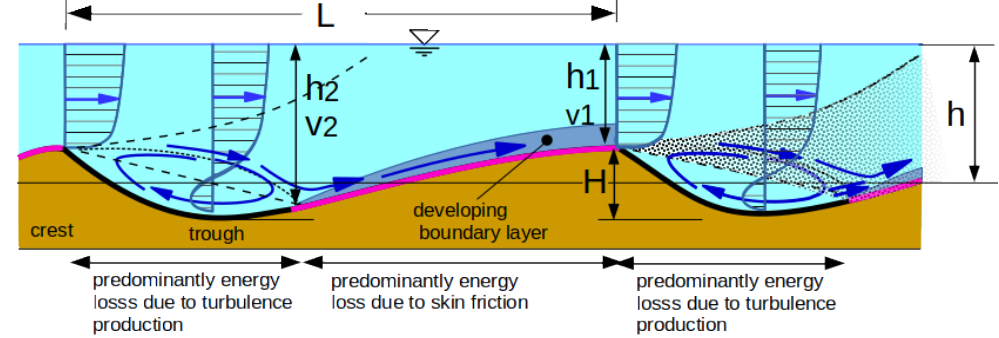
Figure 2. Illustration of the areas with specific flow resistance over sand waves. Dotted lines indicate separation